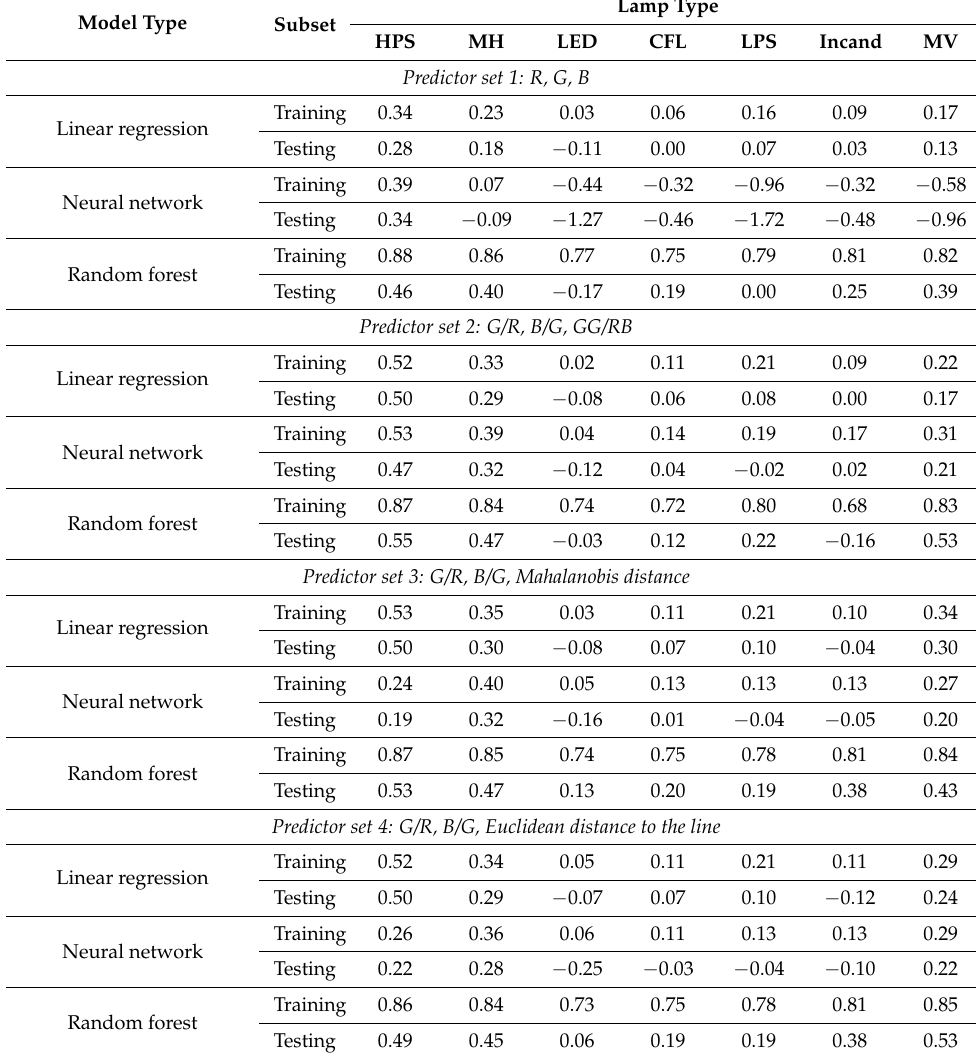
Table 1. The performance of models (in terms of R 2 ) with alternative predictor sets, for the training and the testing sets (dependent variable = relative contribution of a certain lamp